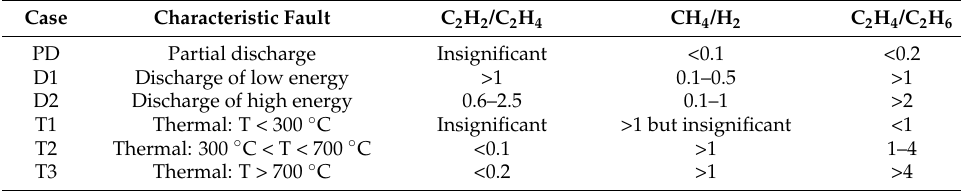
Table 4. Analysis based on IEC